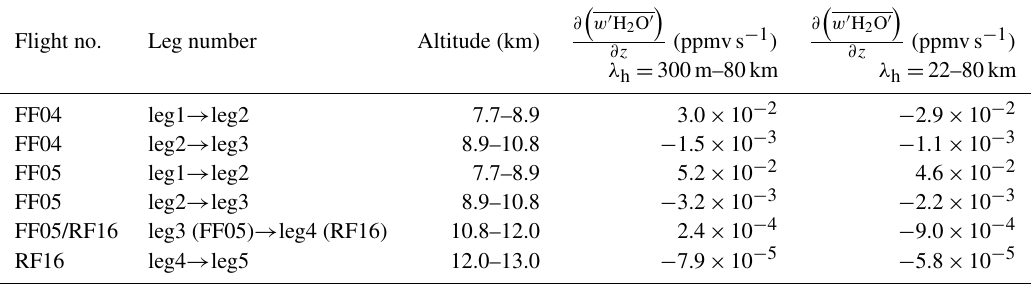
Table 3. Vertical flux divergence of water vapor for the combined research flights FF04, FF05 and RF16. The results are shown for two horizontal wavelength ranges.